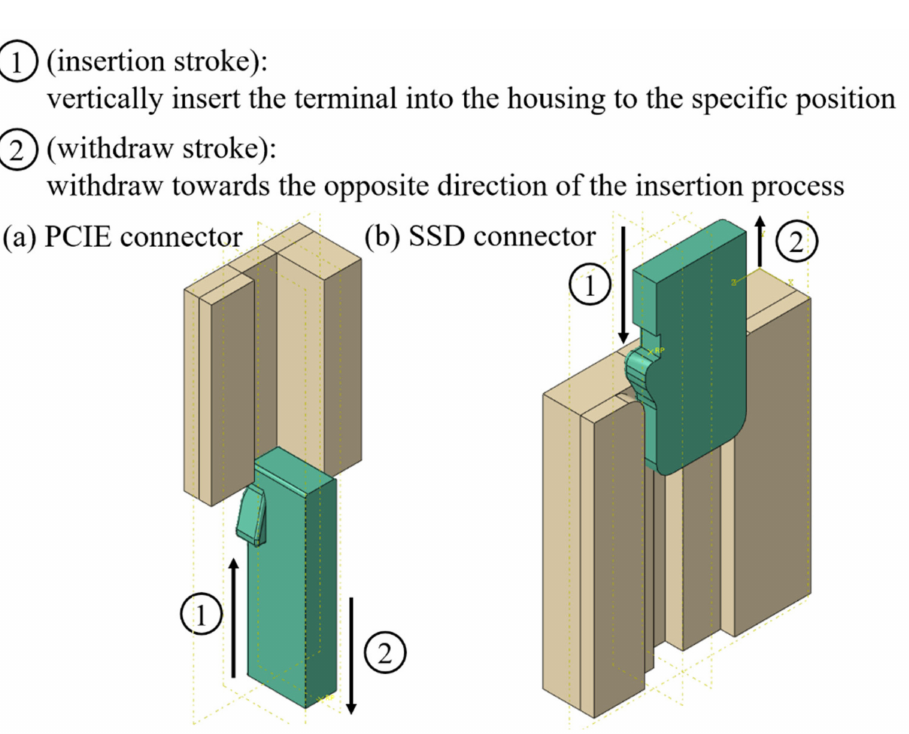
Figure 9. Simplified analysis models of PCIE and SSD